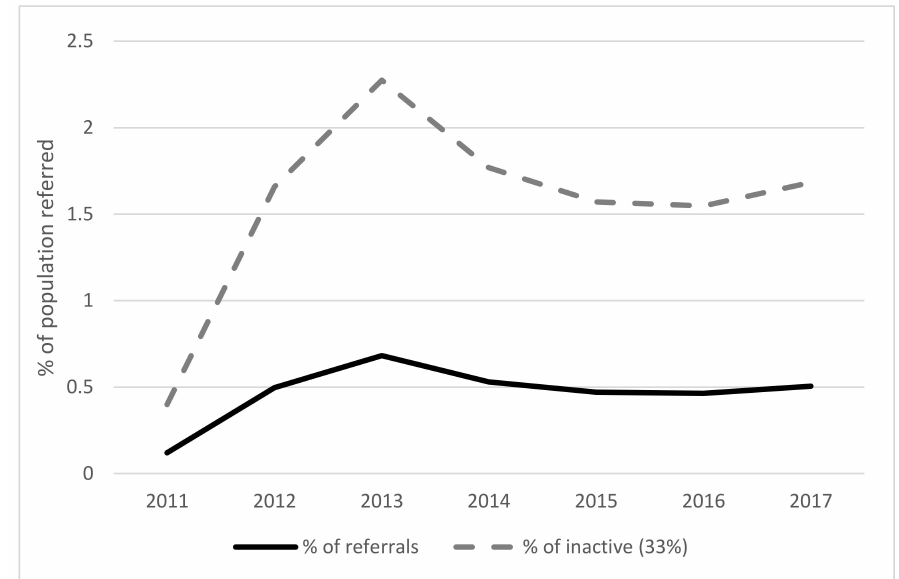
Figure 2. Generic pathway referrals shown as a percentage of the total inactive population in Wales ( N = 83,598 patients).